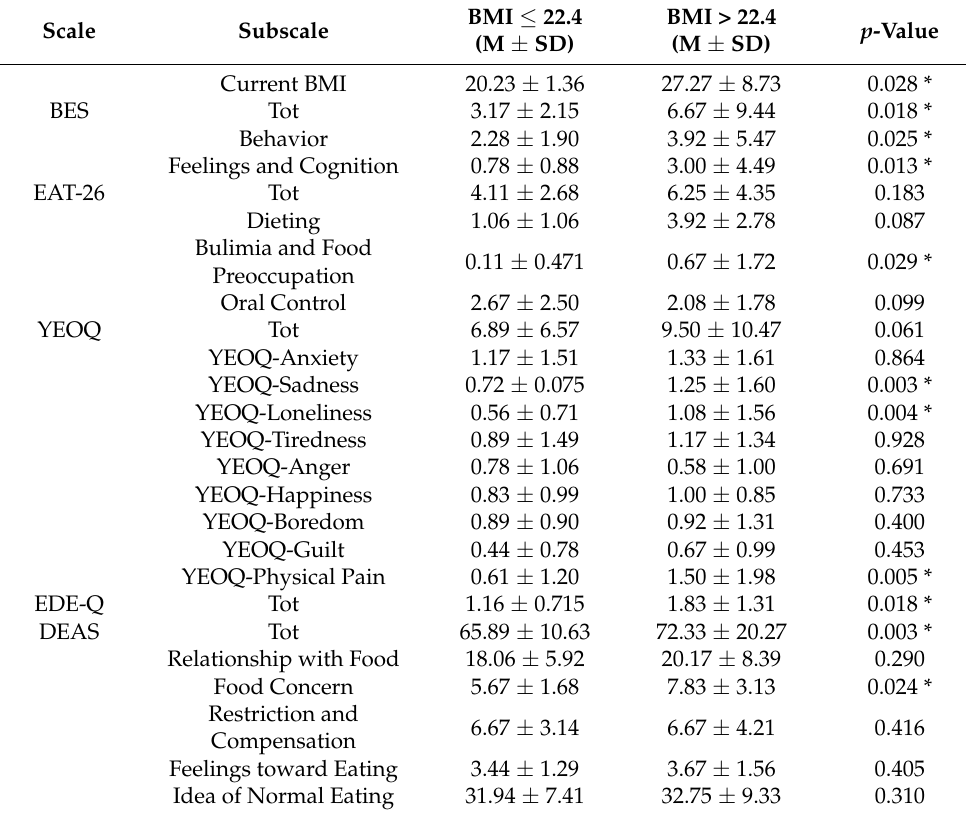
Table 4. Mean scores differences between groups on BMI